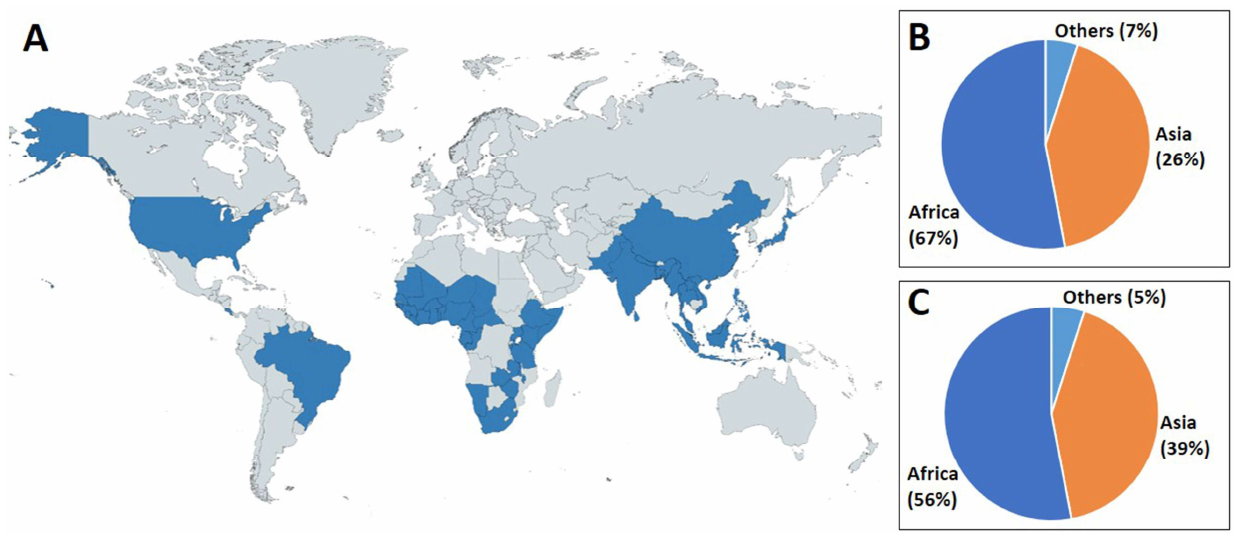
Figure 2. Overview of worldwide distribution of Termitomyces species ( A ) (highlighted as blue color, the map was created using MapChart [69]); type species discovery ( B ) and distribution of species ( C ).